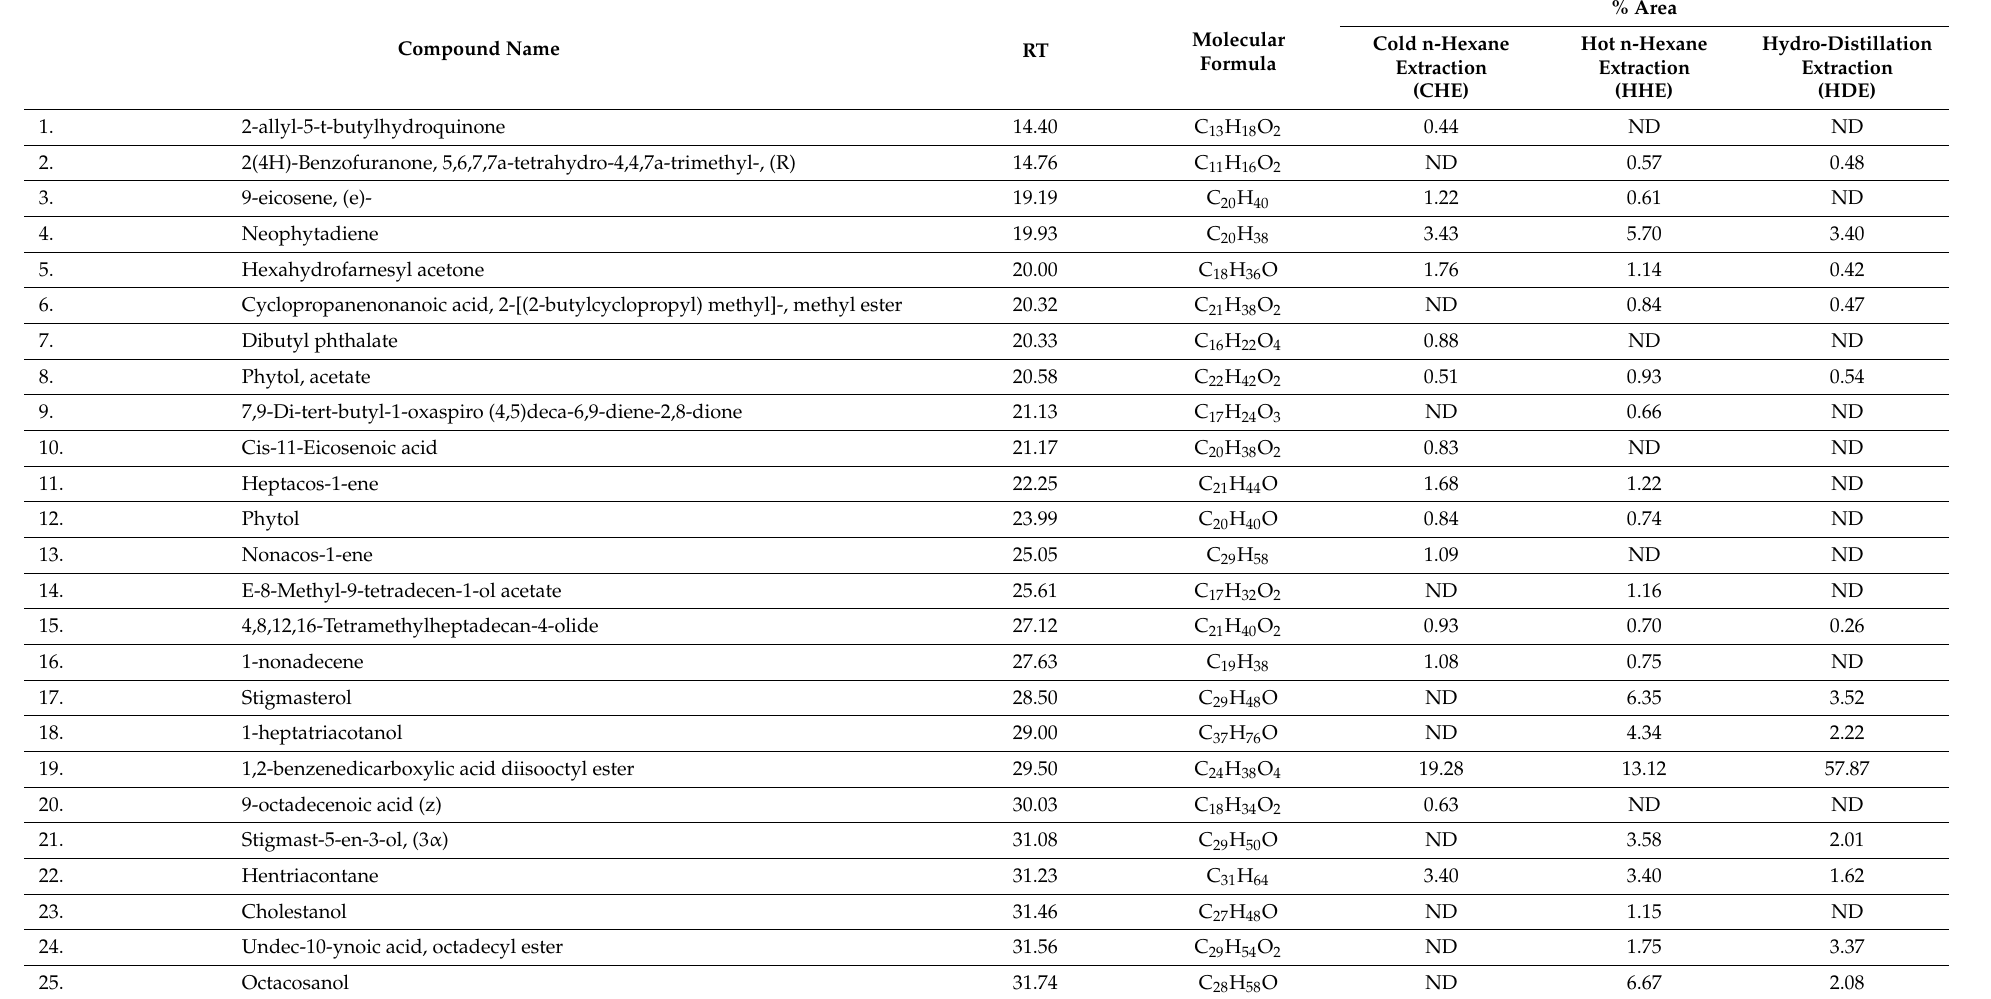
Table 1. GC-MS analysis of the S. aegyptiaca essential oil